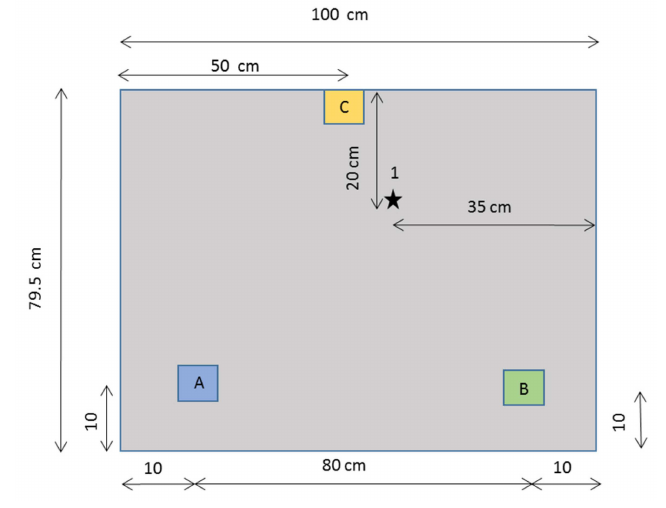
Figure 10. First experiment. Case Study